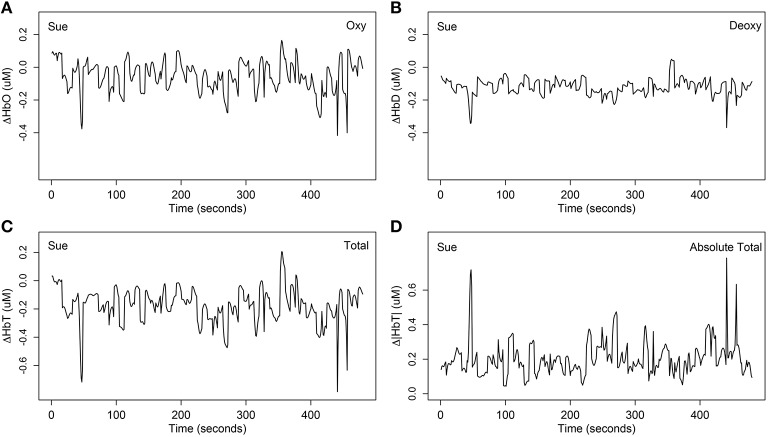
One example of the four different stimulus-relevant hemoglobin categories at channel 31 (mainly overlapped in the right inferior frontal cortex) for Sue. (A) The stimulus-relevant oxygenated hemodynamic curve ΔHbO; (B) the stimulus-relevant deoxygenated hemodynamic curve ΔHbD; (C) the stimulus-relevant total hemodynamic curve ΔHbT; (D) the stimulus-relevant absolute total hemodynamic curve Δ|HbT|. ΔHbT was computed by summing ΔHbO and ΔHbD. Absolute total Δ|HbT| was computed by summing the absolute value of ΔHbO and ΔHbD.